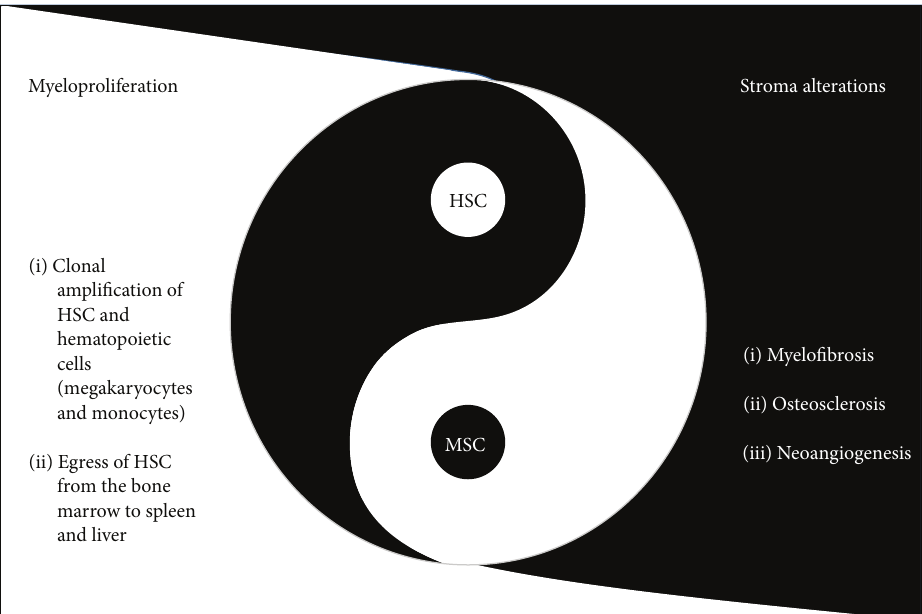
Figure 1: Primary myelofibrosis: the dual complementarity of hematopoietic and stromal stem cells. PMF is characterized by medullar and extramedullary clonal expansion of hematopoietic stem cells (HSCs) and dystrophic megakaryocytes (MKs), altogether with myelofibrosis and osteosclerosis involving fibroblasts and osteoblasts, as well as neoangiogenesis. These elements stand together by growth factors and inflammatory cytokines mediated interactions